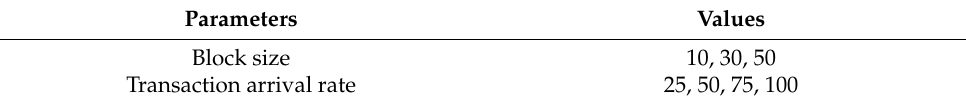
Table 4. Block size (#tansactions) and transaction arrival